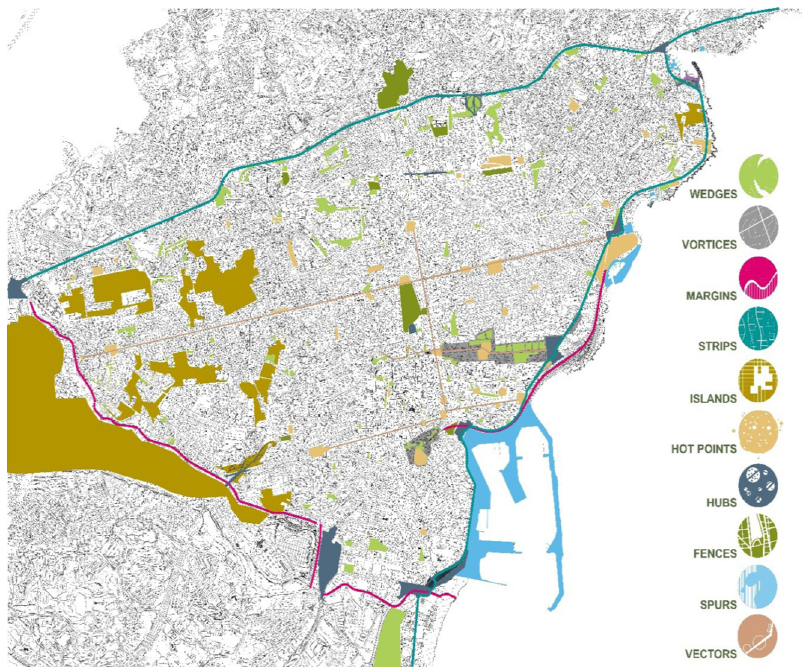
Figure 7. The types of green infrastructures foreseen in the municipality of Catania (2017).